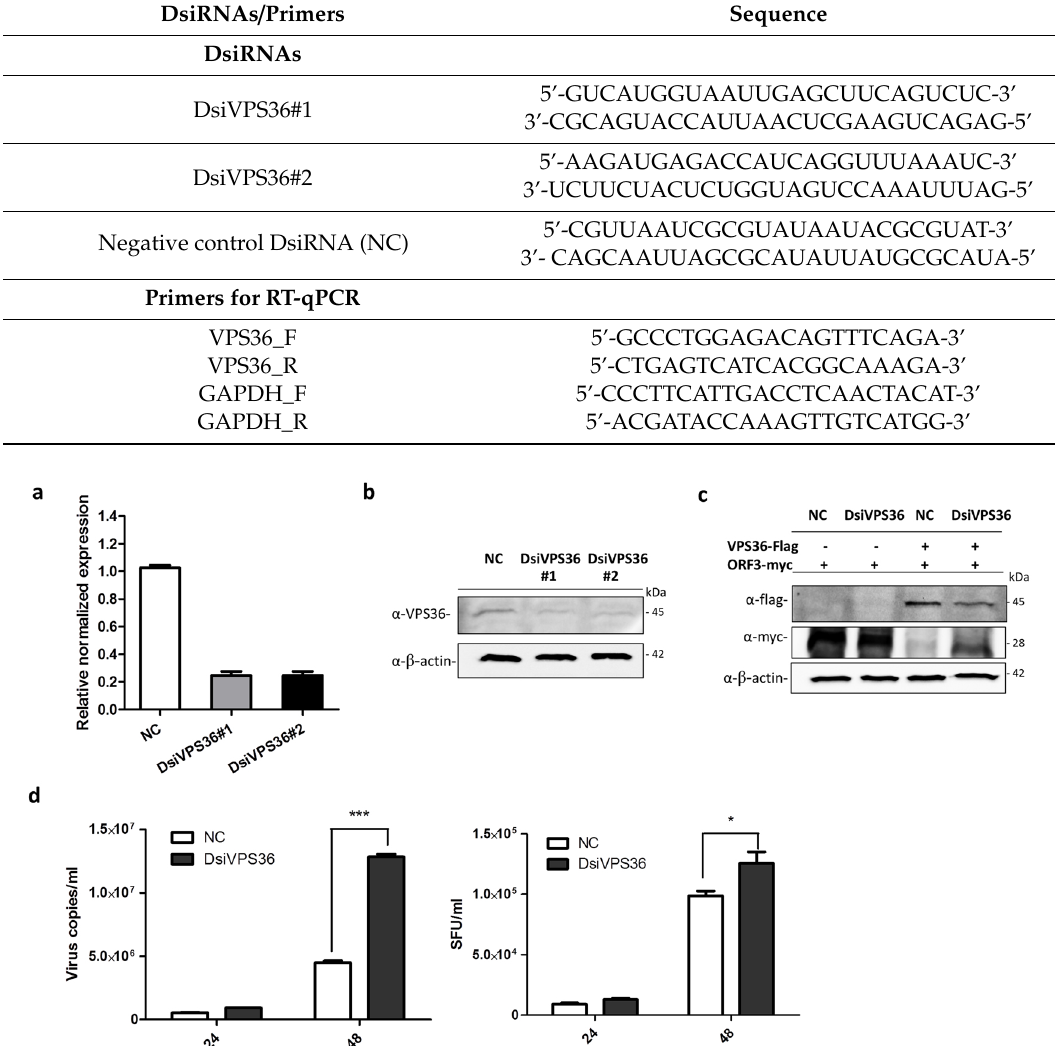
Table 2. DsiRNA and primers used in this study.